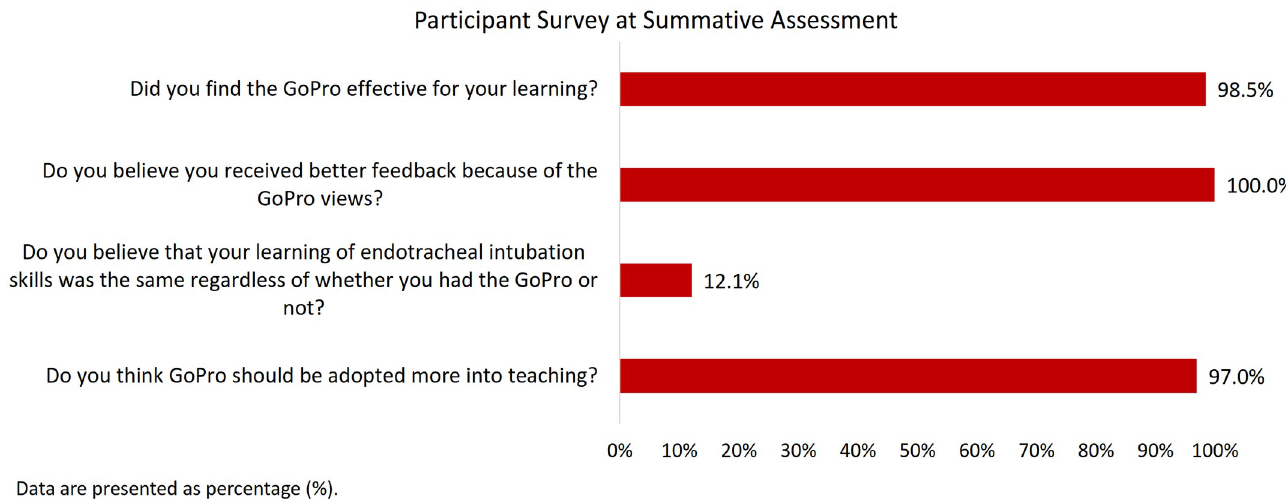
Fig 3. Participant survey at summative